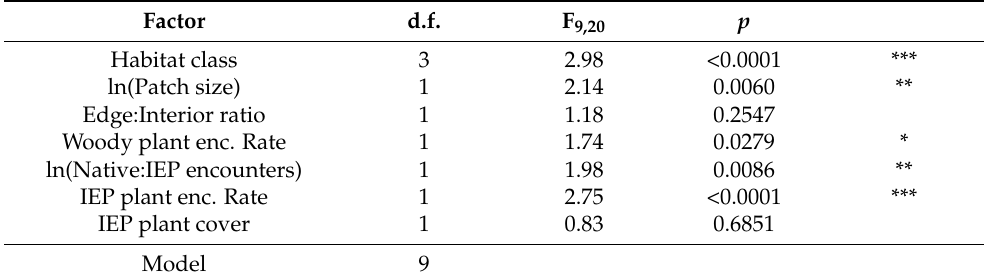
Table 5. PerMANCOVA results examining the effects of habitat type, ln(Native:IEP encounters), wind speed, edge to interior ratio, woody plant encounter rate, blooming plant encounter rate, plant diversity, patch size, and temperature on Lepidoptera community composition. More complex models with additional terms and interactions between terms were considered prior to model pruning. Environmental factors not included here can be interpreted as being insignificant. Legend: